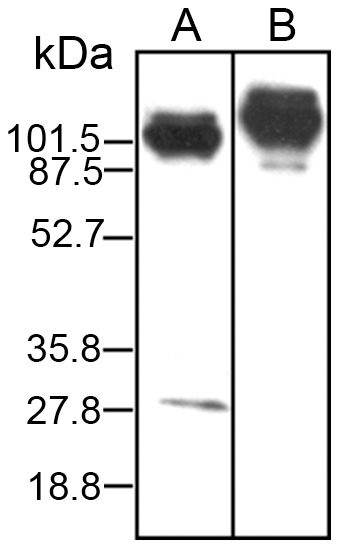
Detection of Bm-wBm protein complexes within crude cross-linked metabolically labeled worm extract using anti-wBm0432 or anti-wBm0152 antibodies.L-Photo-Leucine and L-Photo-Methionine metabolically labeled B. malayi worms were cross-linked for 20 minutes using UV followed by soluble protein crude extract preparation. The soluble extract was passed through an affinity column containing Protein G cross-linked to normal mouse IgG followed by affinity columns containing anti-wBm0432 or anti-wBm0152 antibodies cross-linked to Protein G. The corresponding protein eluates (6 µg/Lane) were run on a SDS-PAGE prior to Western blotting with (A) mouse anti-wBm0432 specific antibodies (bands: ∼110 & 28 kDa) or (B) mouse anti-wBm0152 specific antibodies (bands: ∼90 kDa and ∼120 kDa).